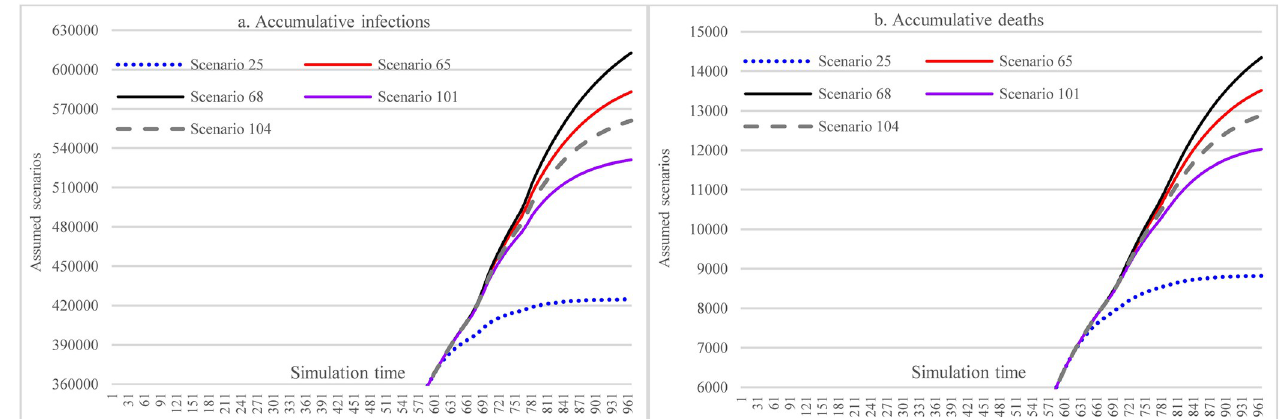
Fig 20. Implementing stringent SDMs versus less stringent SDMs and increased vaccination levels under the mask-wearing adherence level of 48%.